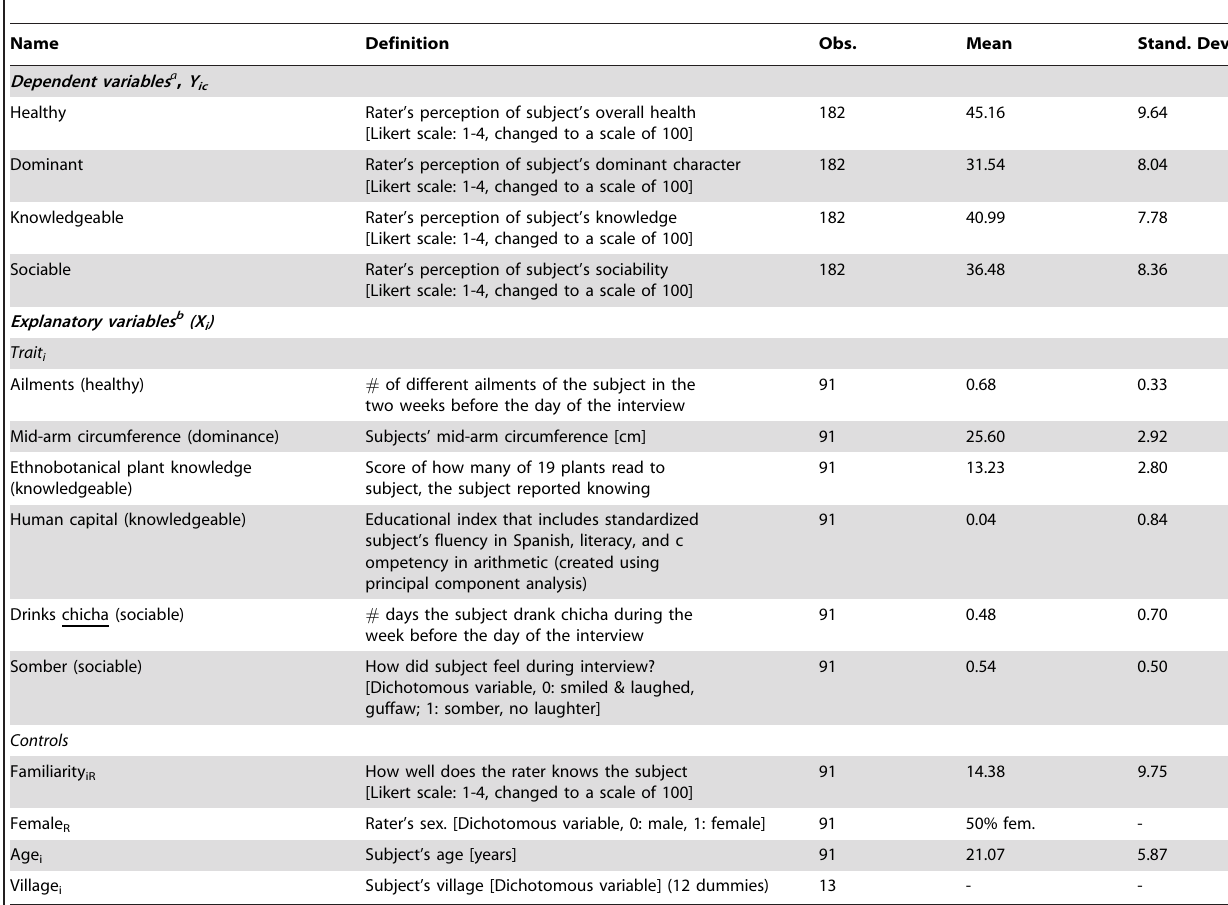
Table 1. Definition and summary statistics of variables used in regressions and equation